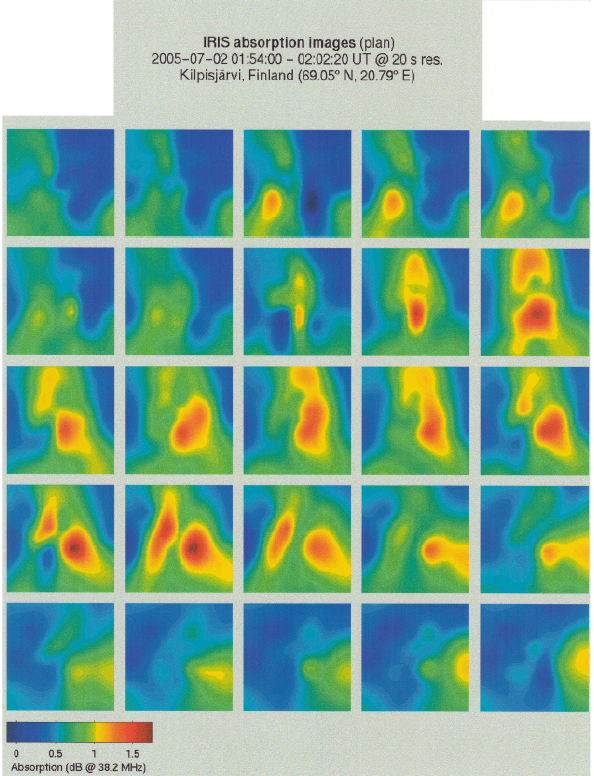
Fig. 11. The morning peak at 01:57 UT at 20s resolution, over the period 01:54:00 to 02:02:20 UT. The field of view covers 240km north-south and east-west, and is presented as if viewed from above.